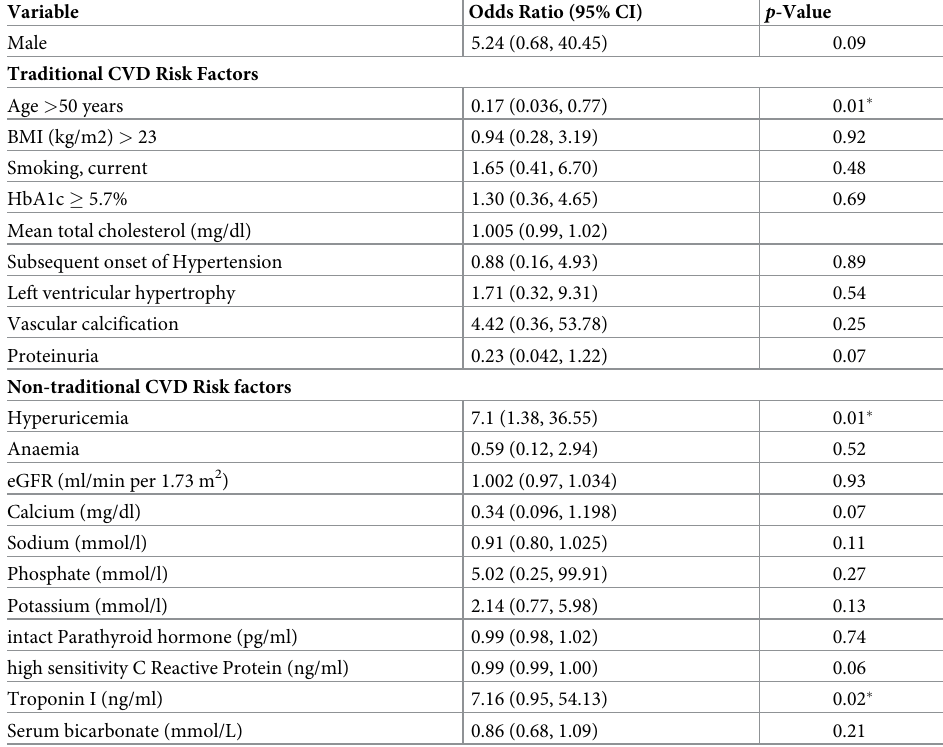
Table 5. Risk factors for the prevalence of IHD in